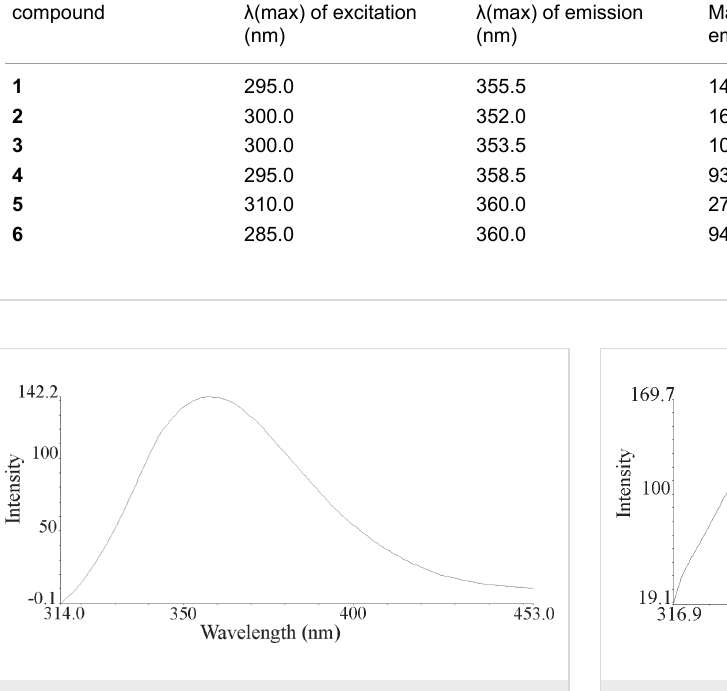
Figure 7: Fluorescence spectrum of compound 1 in methanol.